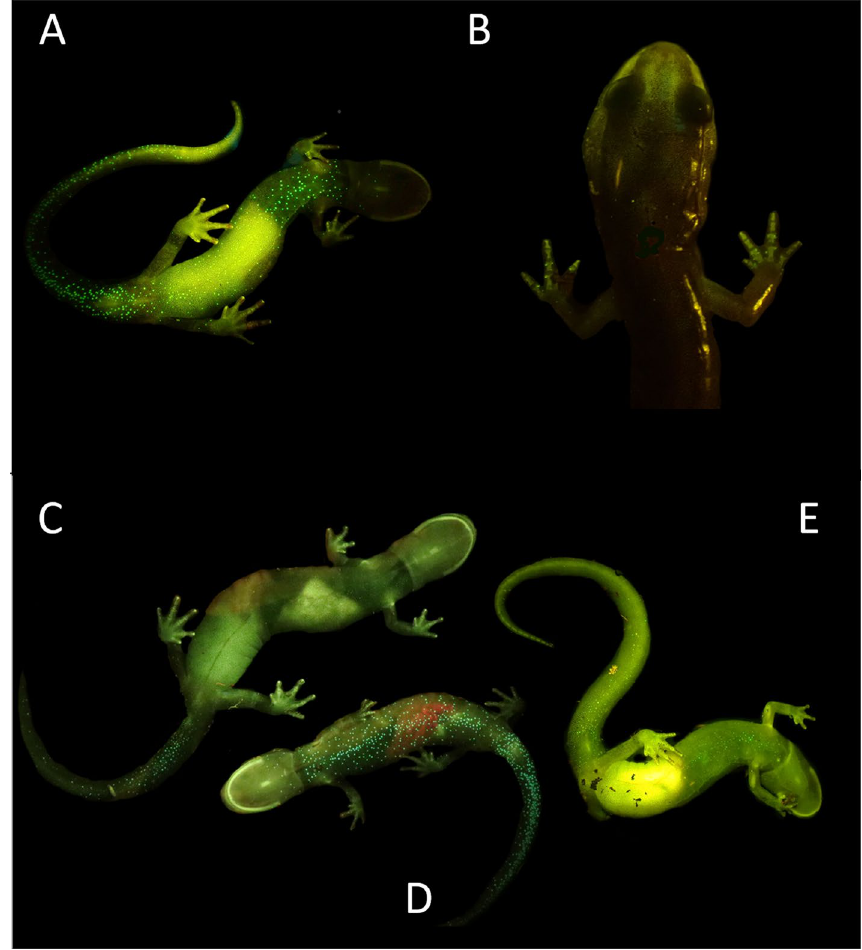
Figure 1. Images of the biofluorescent patterns of P. metcalfi filtered with a 500 nm longpass filter while exposed to blue light. ( A ) Ventral view of a male displaying the biofluorescent speckles. ( B ) Dorsal view of a male displaying the speckling down each digit with fluorescing bones. ( C ) Ventral view of a large female displaying post-cloacal speckling and fluorescent fat stores. ( D ) Male displaying the ventral trunk fluorescent speckles. ( E ) The one large female displaying less intense full ventral trunk